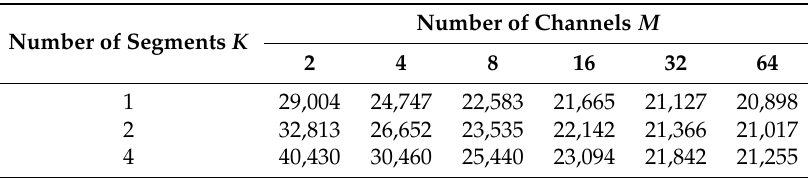
Table 4. The normalized area ( µ m 2 /channel) of the proposed circuit for different numbers of channels M and segments K